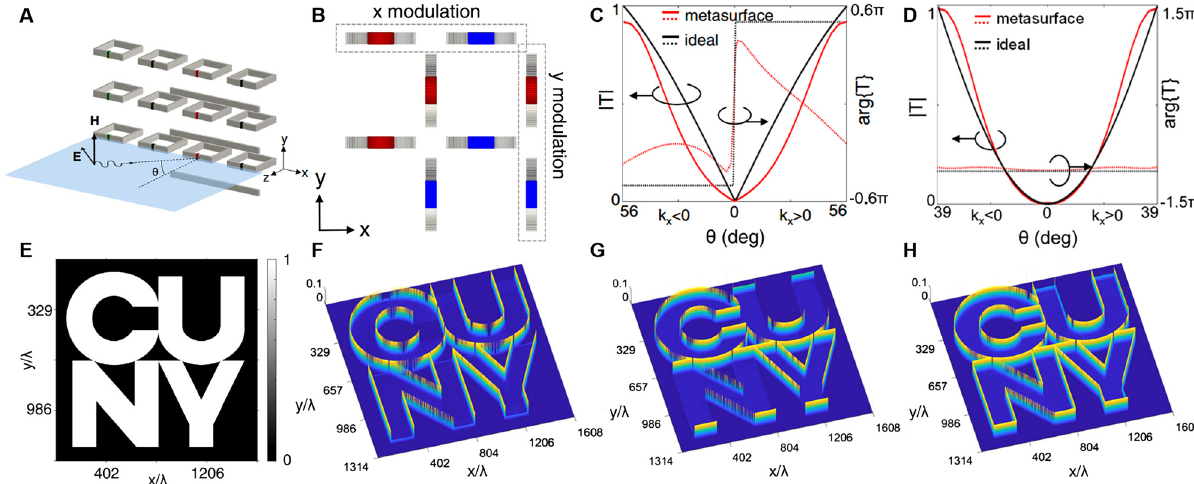
Figure 6: Nonlocal metasurfaces for first-derivative and second-derivative operations [19]. (A)Schematicofametasurfaceconsistingofaperiodicarrayofresonantparticlesinthe x – y plane,formedbysplitringresonators(SRR)parallel tothe x – z plane(magneticdipolemomentparalleltothe y axis).ThemetasurfaceisexcitedbyTMpolarizedwavespropagatinginthe x – z